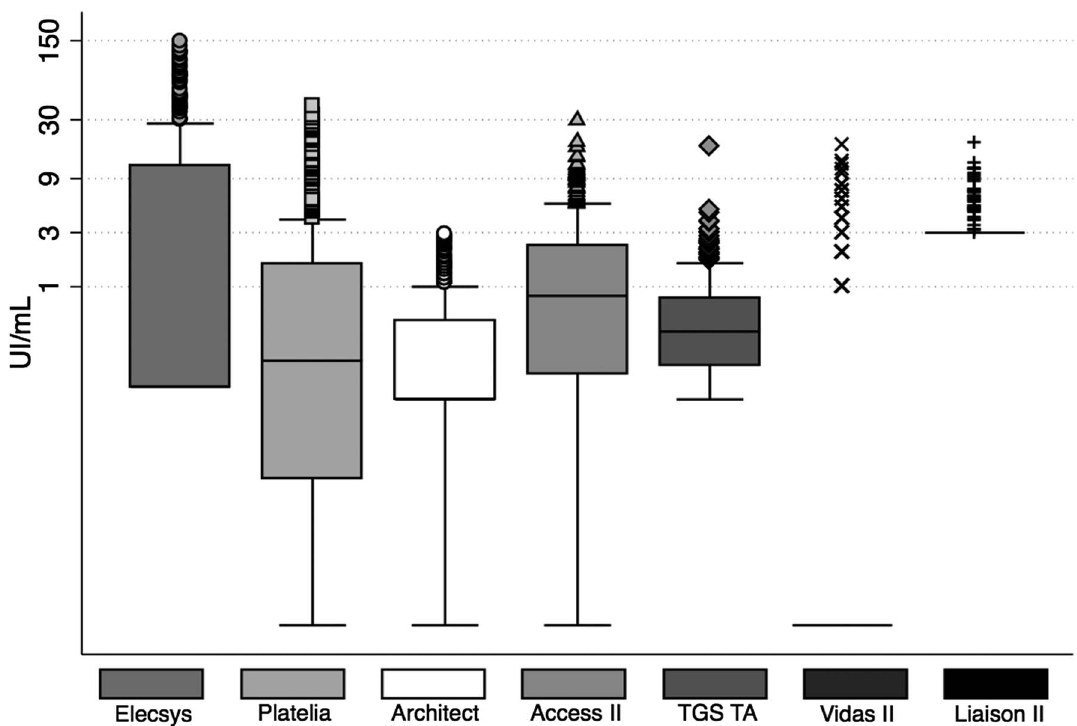
Figure 1. Distribution of the low IgG level sera according to the automated assays.